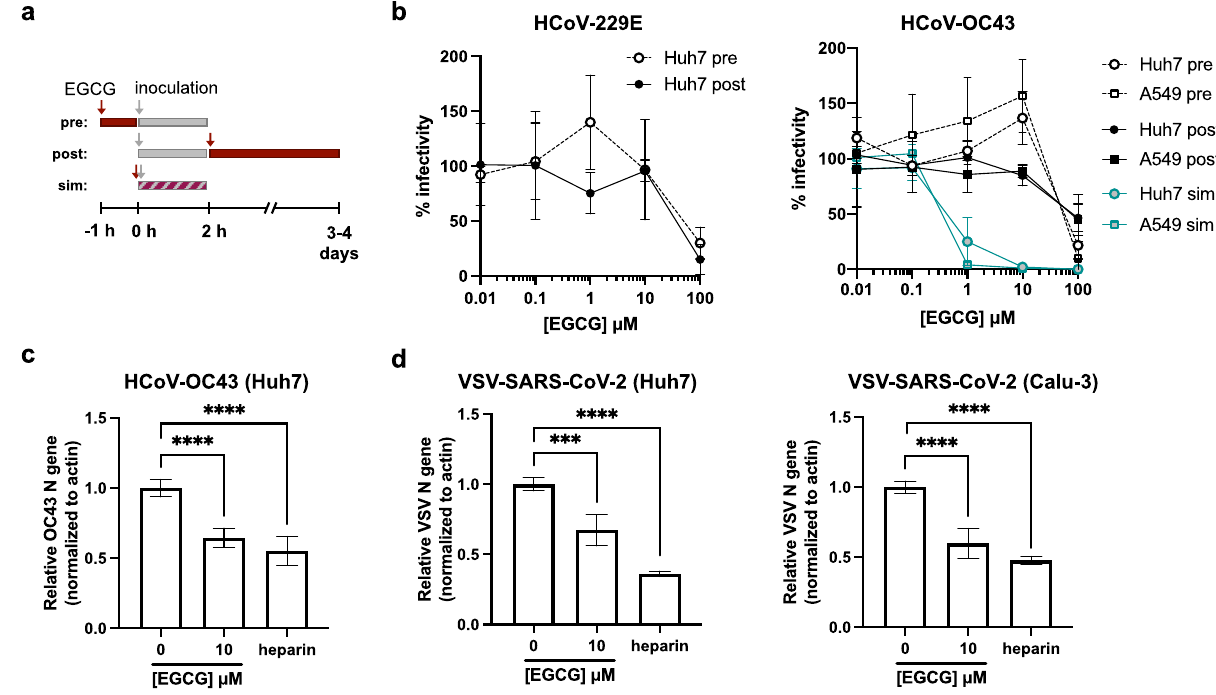
Figure 3. EGCG inhibits CoV attachment to cells. ( a ) Time-of-addition assay showing pre-treatment (pre), post-treatment (post) or simultaneous (sim) treatment of cells. (b) Pre-treatment of cells, or treatment of cells post-infection with HCoV-229E or HCoV-OC43, does not inhibit infection to similar extents as virion pre- treatment. Mean values with standard deviation of three independent experiments are plotted. ( c ) HCoV-OC43 virions were pre-treated with EGCG or heparin for 10 min at 37 °C then cooled on ice and added to pre-chilled Huh7 for 1 h on ice. ( d ) VSV-SARS-CoV-2 were pre-treated as described above and added to pre-chilled Huh7 or Calu-3 cells. Attached virions were quantified by RT-qPCR after washing cells with phosphate buffered saline (PBS) three times. Mean values with standard deviation from qPCR triplicates of two independent experiments are plotted. Statistical significance was assessed by Welch’s t test (*** p < 0.001, **** p <